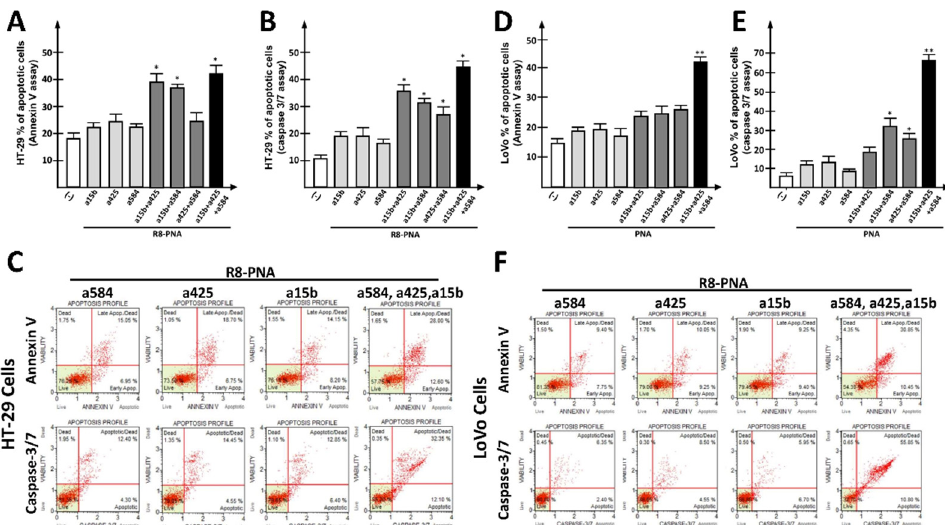
Figure 4. Effects of PNA combinations on apoptosis induction. ( A , D ) Effects of combinations of anti-miRNA PNAs on apoptosis induction in HT-29 ( A ) and LoVo ( D ) cells treated for 72 h with a 4 µM concentration of each PNA, as determined using Annexin V assay. Singularly administrated PNA (light gray boxes), combinations of two PNAs (dark gray boxes), triple-PNA combination (black box). The apoptotic profile was determined using Annexin V assay. ( B , E ) Effects of anti-miRNA PNA combinations on apoptosis induction in HT-29 ( B ) or LoVo ( E ) cells treated for 72 h with a 4 µM concentration of each PNA, as determined using Caspase 3/7 assay. Singularly administrated PNA (light gray boxes), combinations of two PNAs (dark gray boxes), triple-PNA combination (black box). ( C , F ) Representative plots obtained by Annexin V (upper line) and Caspase 3/7 (lower line) assays in HT-29 ( C ) or LoVo ( F ) cells. (* p < 0.05, ** p < 0.01, double-PNA treatment was compared with singularly administrated PNA, while triple-PNA treatment was compared with double-PNA combinations. n = 3 independent experiments).